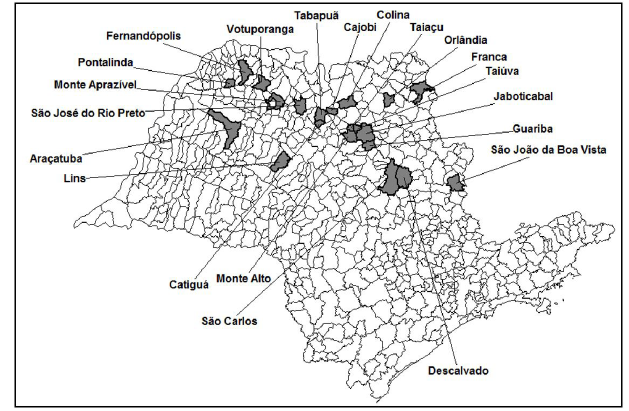
Figure 1. Geographic location of the municipalities of the State of São Paulo, Brazil, where they found the cattle herds sampled for rotavirus detection, from 2006 to 2010. Table 1. Number of samples collected in dairy and beff herds from 21 municipalities in the northern region of the State of São Paulo, from 2006 to